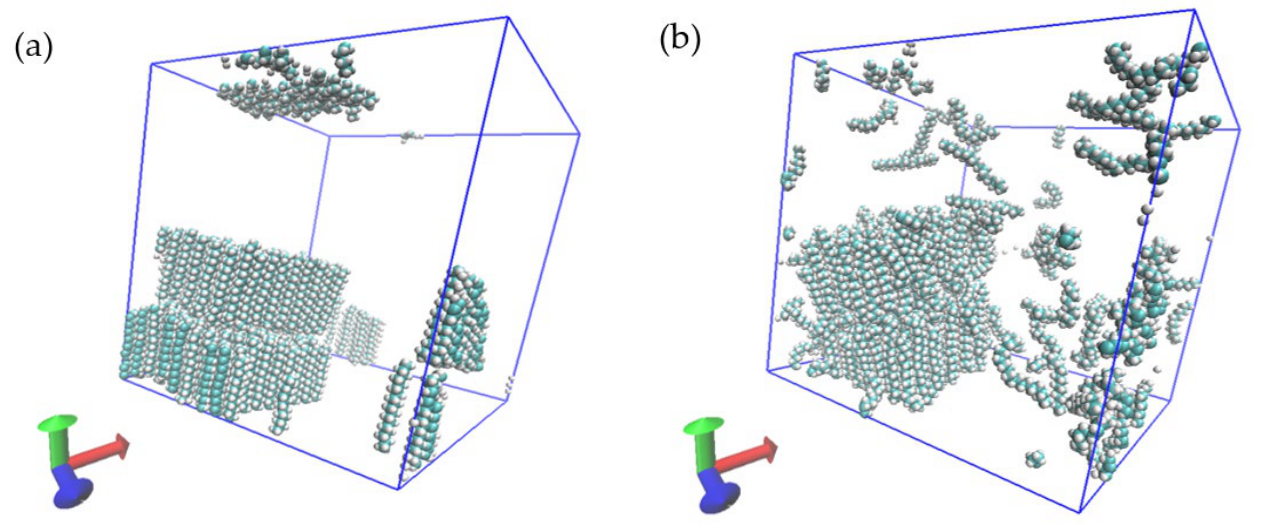
Figure 6. Snapshot of the initial NA molecules of case 3 at 7.2 ns at ( a ) −3 .15 °C and ( b ) 28.85 °C. Molecules are cutoff due to the periodic boundary condition.